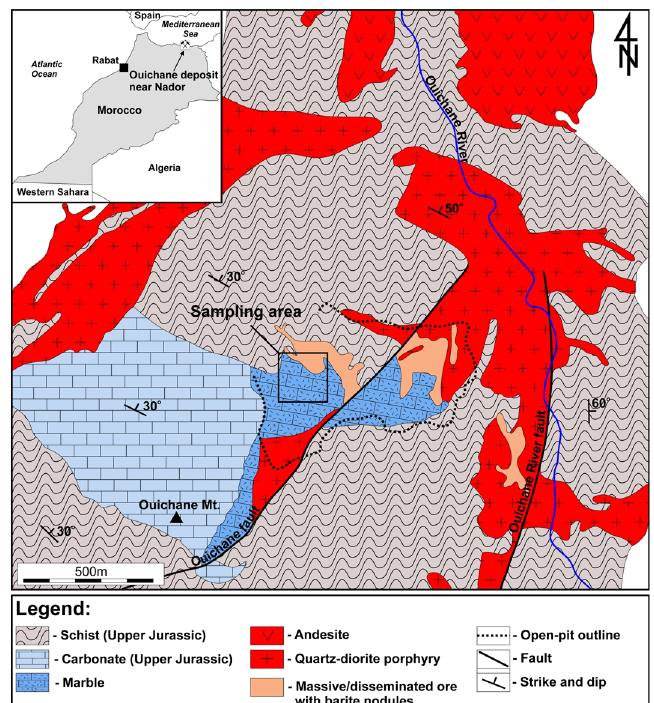
Figure 1. Geological map showing main lithologies found in the vicinity of Jebel Quichane area, modified after Bouabdellah et al. 21